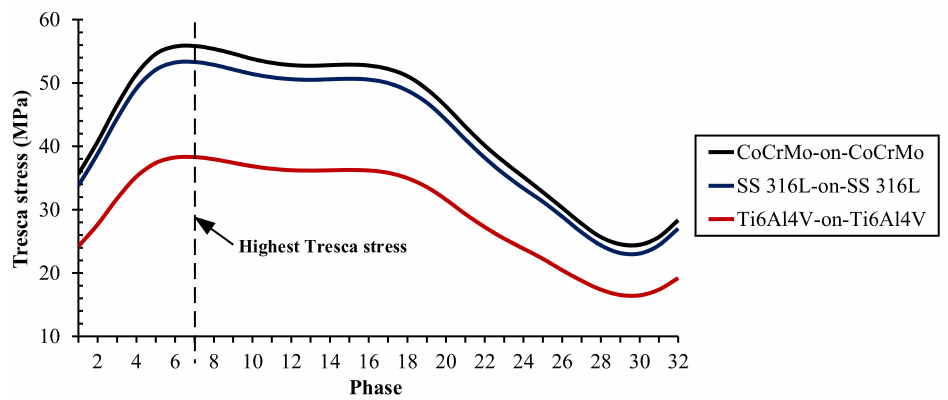
Figure 3. Maximum Tresca stress for different metal-on-metal bearing materials in full cycle.